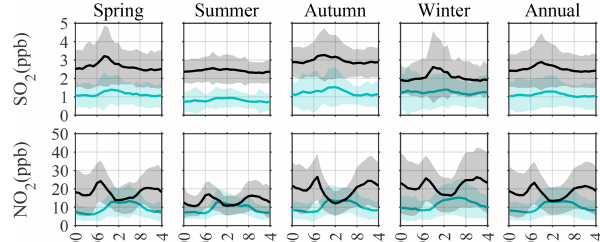
Figure 8. Diurnal variations of SO 2 (ppb) and NO 2 (ppb) observed at SHT (blue line) and SUR (black line) in four seasons and the en- tire observation period. The line stands for mean value. The shaded area represents the standard